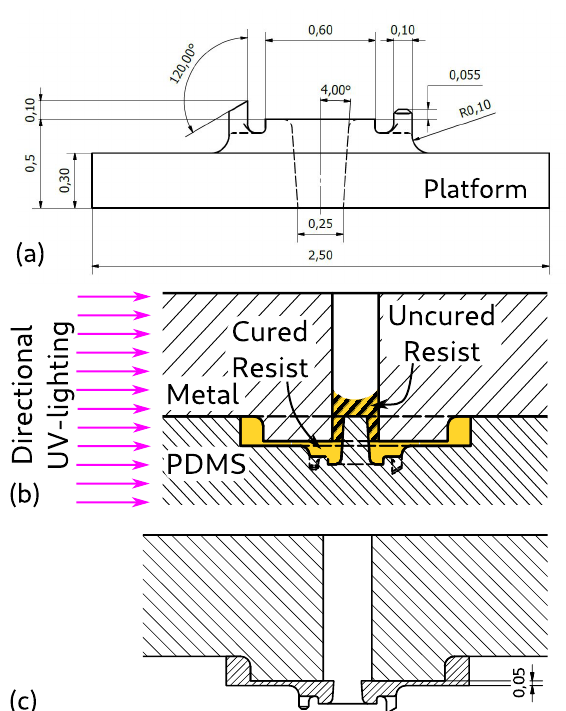
Figure 8. ( a ) Micromanufacturing design for Nanoscribe Manufacturing (dimensions in mm) ( b ) Zoom on the moulding composition near the liquid channel. ( c ) Zoom on the final gripper